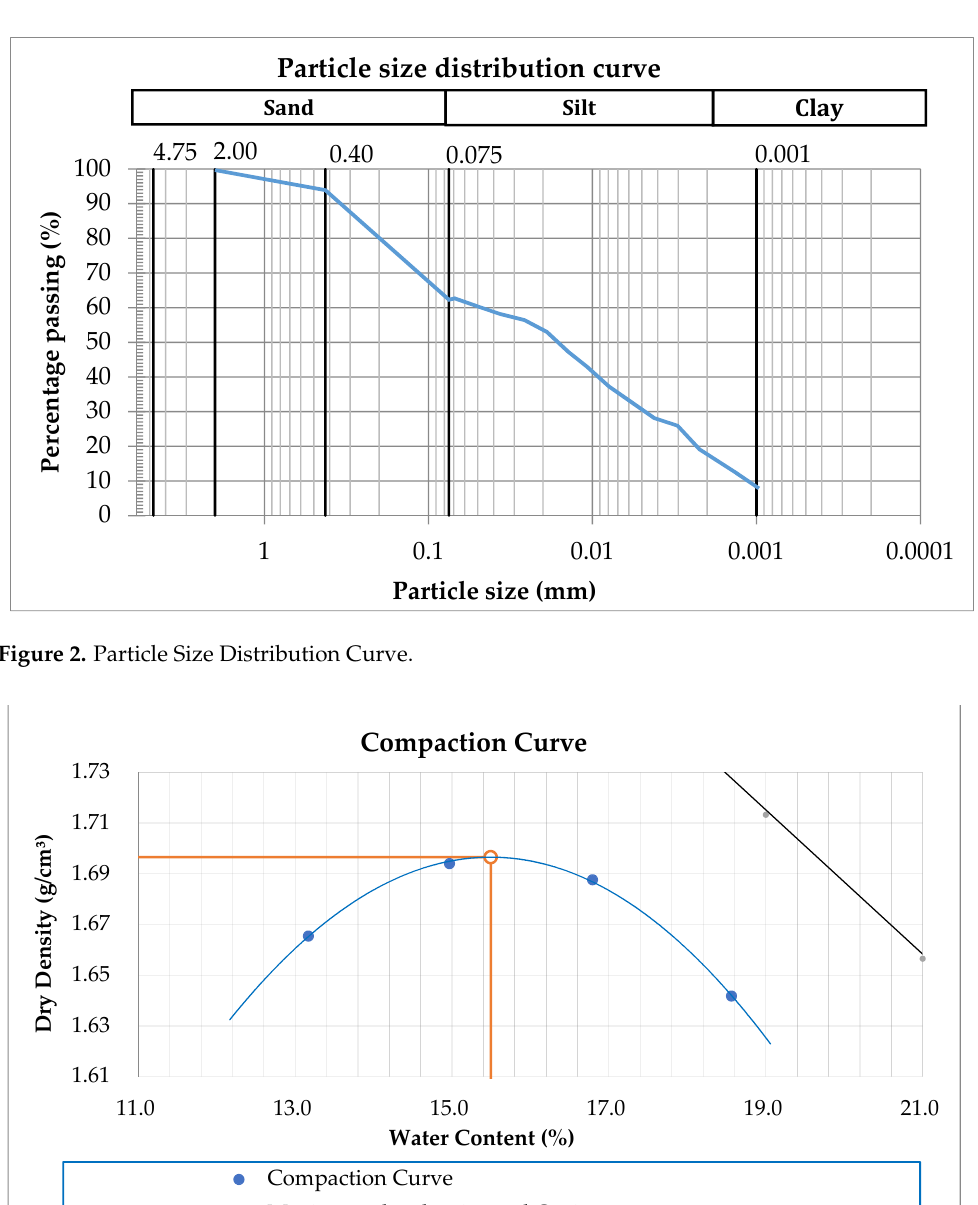
Figure 3. Soil Compaction Curve.